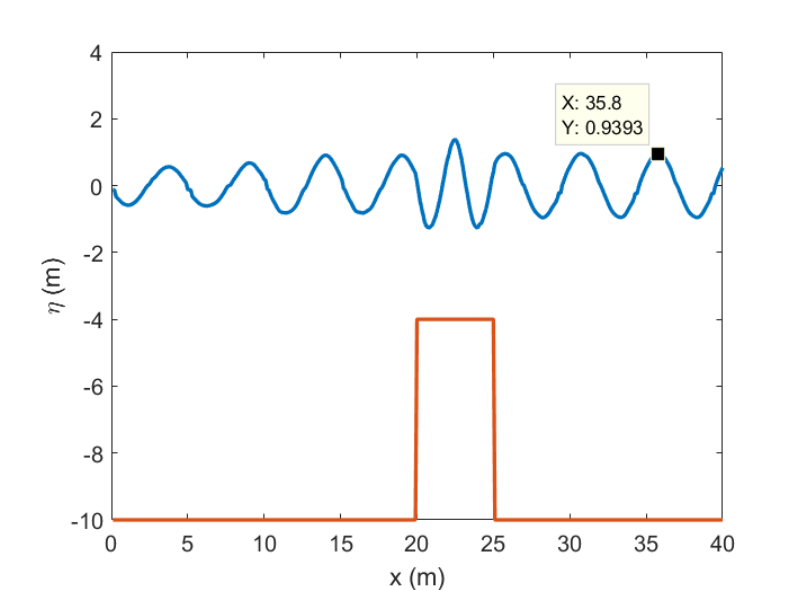
Figure 6. Numerical model figure result with A i = 1 m, wave period 0.5 s, h 0 = 10 m, L = 5 m and h 1 = 4 m.